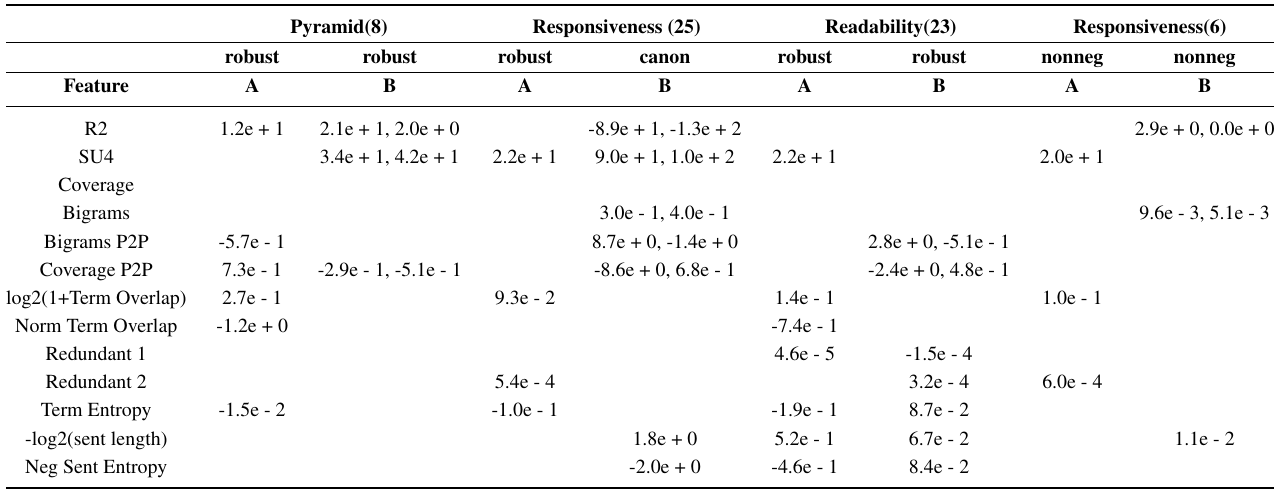
Table 3. Features used when only predicting scores of machine